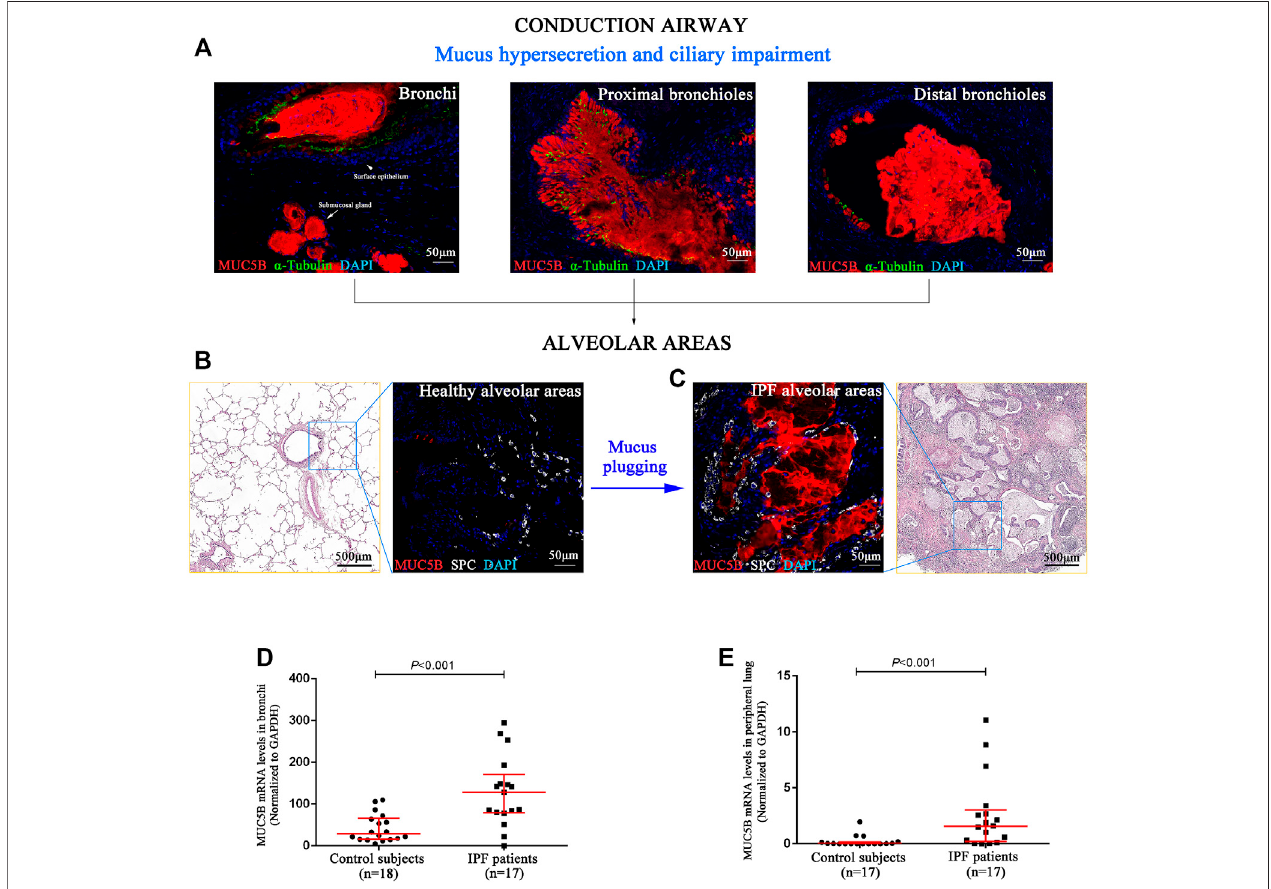
FIGURE 5 | MUC5B + mucus plugging in conducting airway lumens and alveolar regions. The IF staining showing obvious MUC5B + mucus (red) secreted in conducting airway lumensin IPFpatients (A) .Arepresentative H&Estainingofperipheral lung tissue fromacontrol subject, showing thatboth thedistal bronchioles and alveoli have normal size and architecture, without fi brosis or in fl ammation around (B) . A representative H&E staining of honeycomb fi brosis (characterized by cystic fi brotic airspaces that are frequently lined by bronchiolar epithelium and fi lled with mucus and in fl ammatory cells) in peripheral lung tissue from an IPF patient (C) . Compared with control subjects (B) , we found obvious MUC5B + mucus plugging in alveolar regions (SPC-positive for alveolar type 2 cell) (C) . As compared to the controls, the MUC5B mRNA levels were signi fi cantly higher in both the bronchi (D) and peripheral lung (E) tissues of IPF patients, respectively. DAPI labeling of nuclei (blue). DAPI, 4 ′ ,6-diamidino-2-phenylindole; IF, immuno fl uorescence; IPF, idiopathic pulmonary fi brosis; MUC5B, mucin 5B; SPC, surfactant protein C.